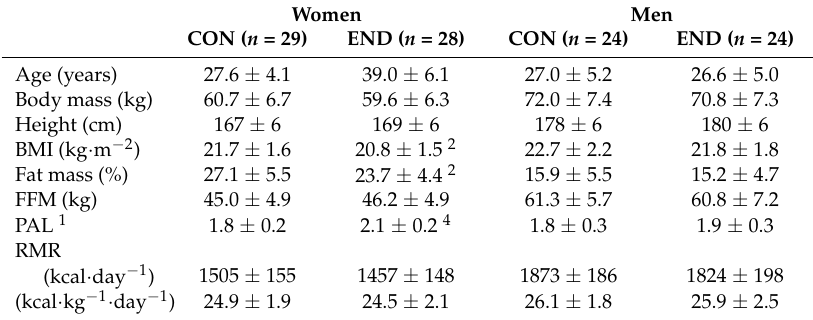
Table 1. Overview about included endurance trained participants (END) and healthy controls (CON) with a valid resting metabolic rate (RMR) and maximum oxygen consumption (VO 2 max) measurements. Data are presented as Mean ±